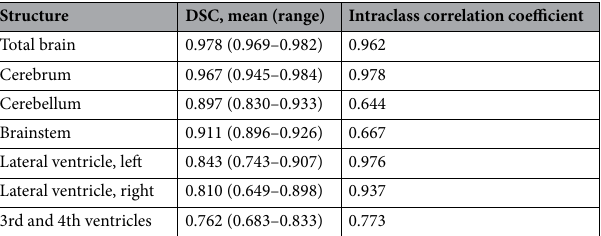
Volume reduction in the infants with CHDs in ml (standard error)